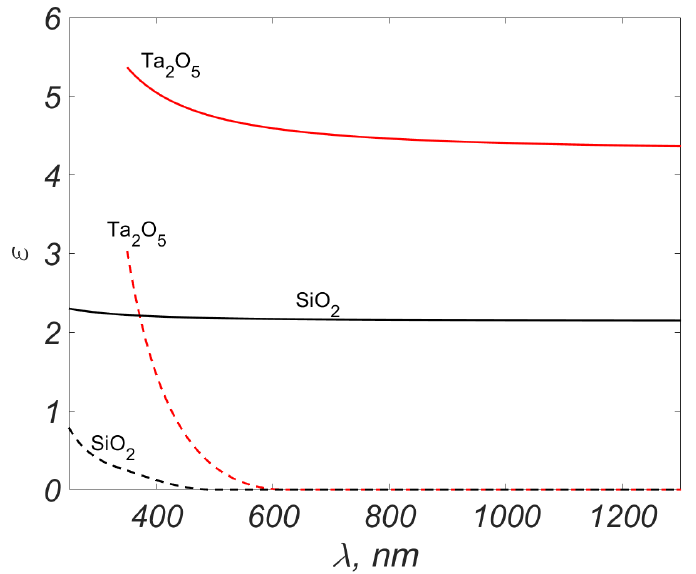
Figure 9. The dependence of the dielectric permittivity ε on the wavelength λ [47,48]. Red lines are Ta 2 O 5 , black lines are SiO 2 . Solid lines stand for Re ε , dashed lines are for 10 3 · Im ε .